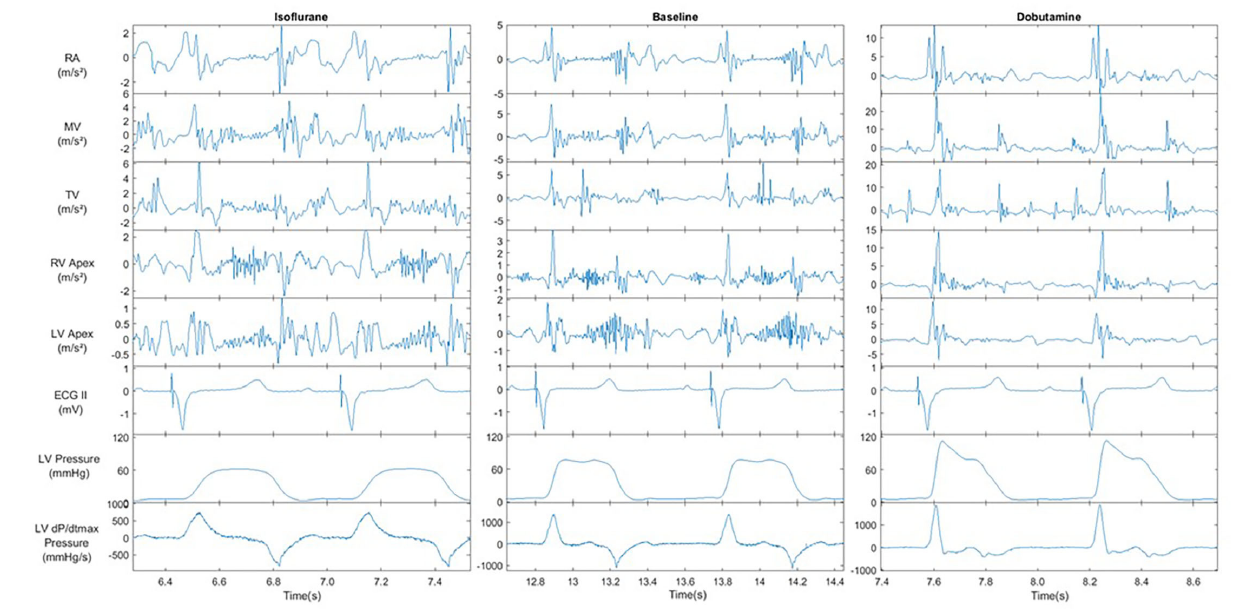
FIGURE 4 | Recorded signals of Left ventricular pressure, ECG and all acceleration recording sites under the influence of cardiovascular modifiers. All signals were recorded @BIV | AVd = 150ms | VVd = 0. Acceleration signal show the result of the X, Y and Z axis magnitude filtered between 1-150Hz. AVd = atrio-ventricular delay, VV = intra-ventricular delay.